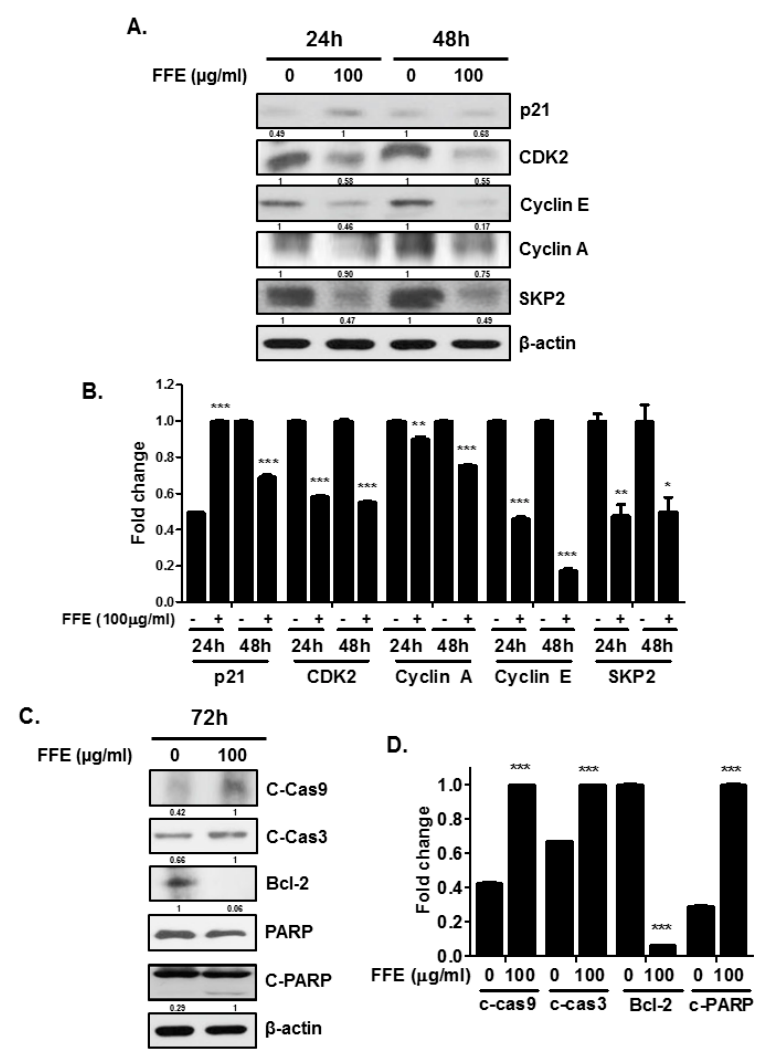
Figure 3. Effect of FFE on cell cycle arrest and apoptosis in MDA-MB-231 cells. MDA-MB-231 cells treated with FFE for 24 h, 48 h, and 72 h. ( A ) Cell lysates prepared and subjected to Western blotting for cell cycle-related proteins (p21, CDK2, cyclin E, cyclin A, SKP2 and β actin). ( B ) Fold change of Western blot. Data represent mean ± SD, * p < 0.05, ** p < 0.01 and *** p < 0.001 compared with control. ( C ) Levels of apoptosis-related proteins (C-Cas9, C-Cas3, Bcl-2, PARP, C-PARP and β -actin) determined by Western blot analysis. Fold change of Western blot. ( D ) Data represent mean ± SD, * p < 0.05, ** p < 0.01 and *** p < 0.001 compared with control.